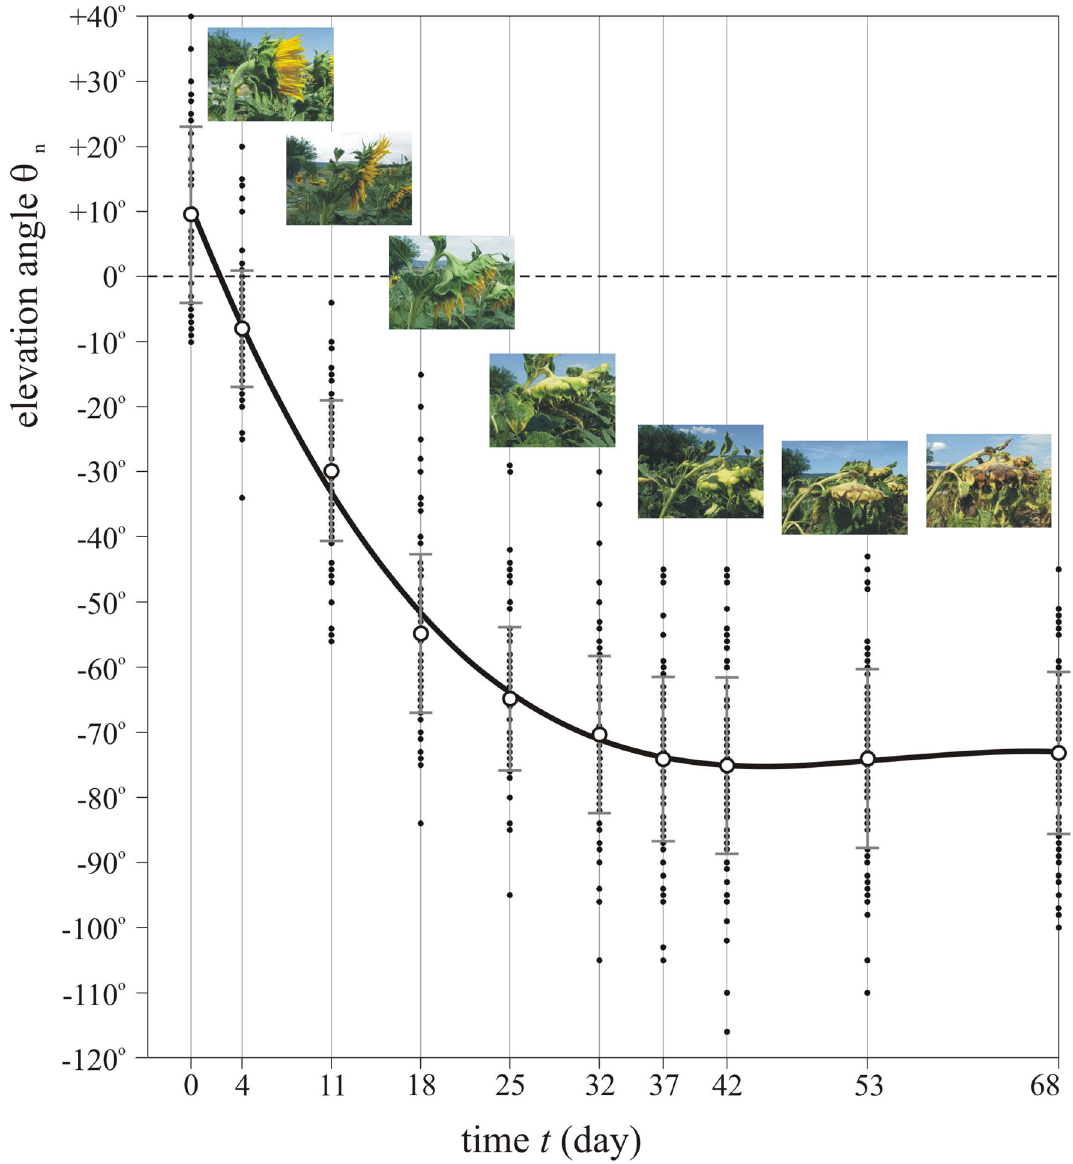
Figure 3. Elevation angle of mature sunflower heads versus time. Elevation angles θ n of the normal vector of the mature head of 100 sunflowers as a function of time t given in day after anthesis. Small black dots show the individual θ n -values relative to the horizontal, while the large circles and vertical bars represent the mean and standard deviation. The solid black curve is the cubic function θ n ( t ) = at 3 + bt 2 + ct + d with a = − 5.65747017 × 10 –4 , b = 9.34138559 × 10 –2 , c = − 4.96385037, d = 10.4936951 fitted to the data points. The insets show typical sunflower heads (with increasing age from left to right) photographed by Gábor Horváth from the side. The horizontal positions of these pictures do not correspond exactly to the time represented by the vertical